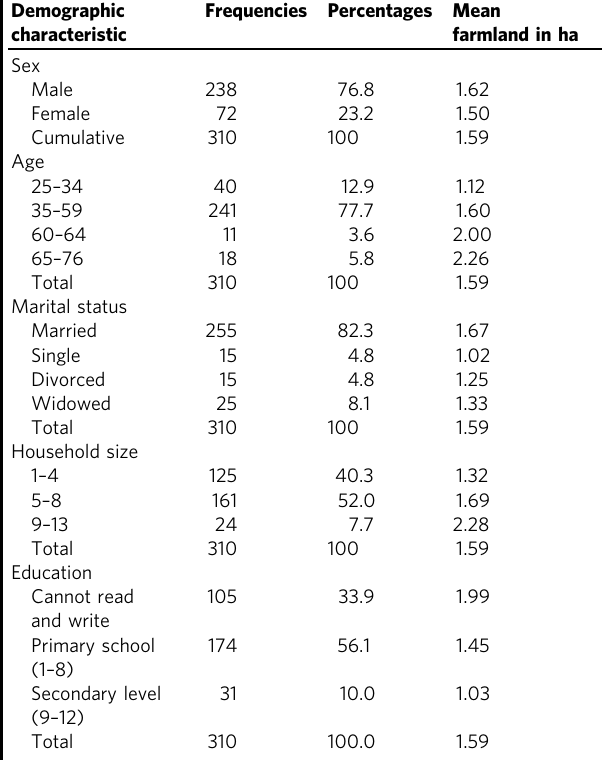
Table 1 Explanatory variables description, measurements and expected signs.